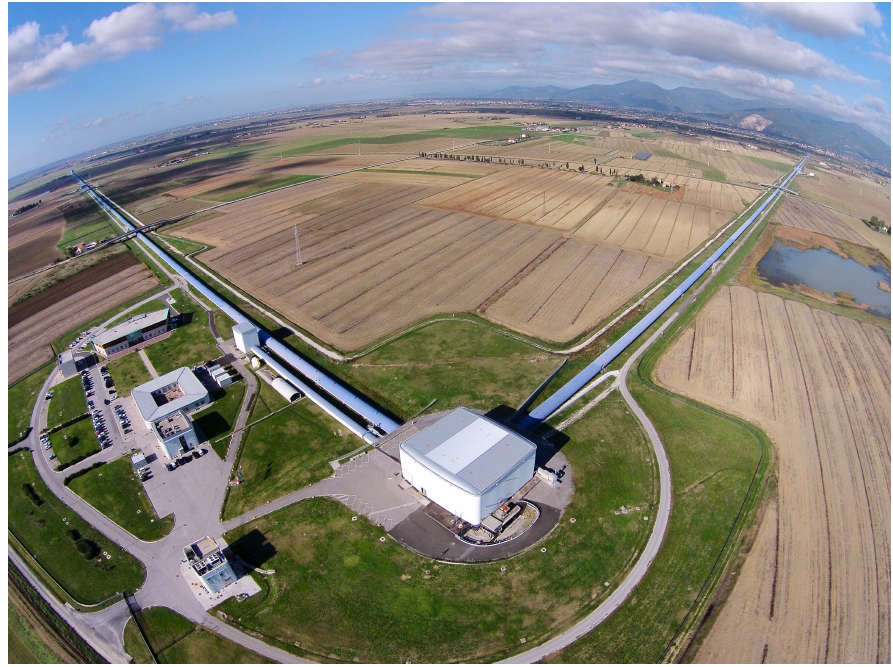
Figure 1. Aerial view of the Virgo site in Cascina (Pisa, Italy). Credit: The Virgo Collaboration. In 2000, the European Gravitational Observatory (EGO) consortium was founded by INFN and CNRS and tasked with the supervision, the construction and the operation of the detector, under the direction of the two funding